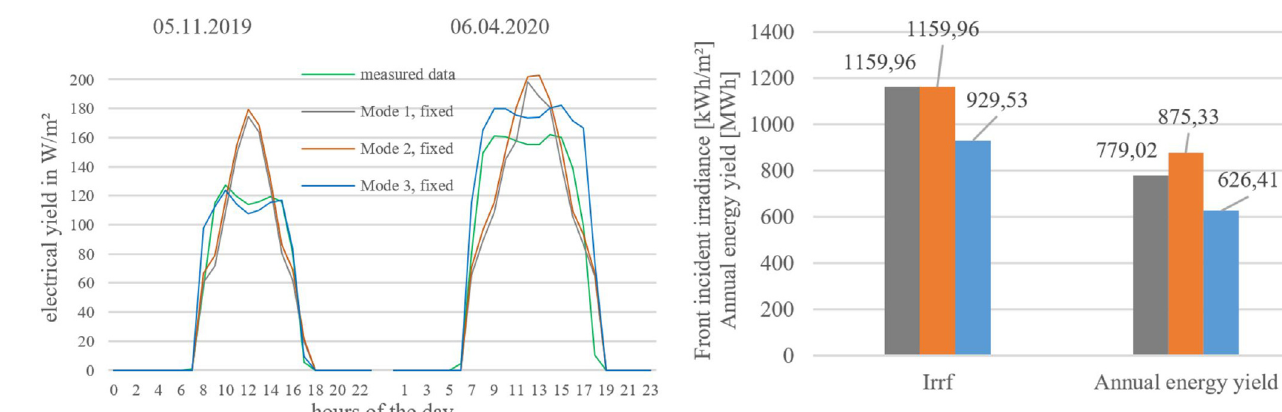
Figure 4. Here two selected daily courses of the simulated and measured electrical energy yield are shown. On the left side of the diagram the 05.11.2019 and on the right side the 06.04.2020 are shown. On 05.11.2019, it can be seen that